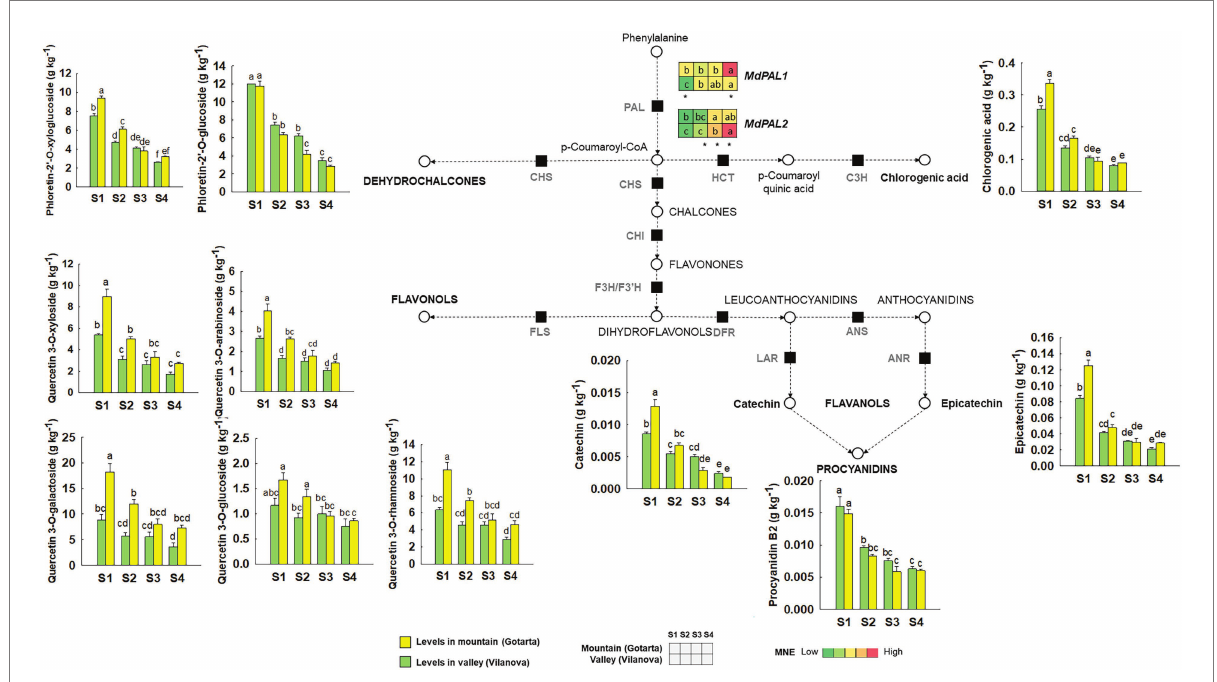
FIGURE 4 Comparison of phenolic compounds metabolism in “Golden Reinders” apples grown in (Gotarta- ) or valley (Vilanova- ) orchards during fruit development/ripening. Dashed lines indicate that some steps have been omitted. Phenolic compounds are represented in plots. Error bars represent the standard error ( n = 4). Letters, whenever available, indicate significant differences for the interaction location*developmental stage according to Tukey’s test ( p ≤ 0.05). The corresponding transcript levels of the main genes are represented as heatmaps. Letters within the heatmaps indicate significant differences ( p ≤ 0.05) between development stages, while asterisk denote differences among locations at each specific development